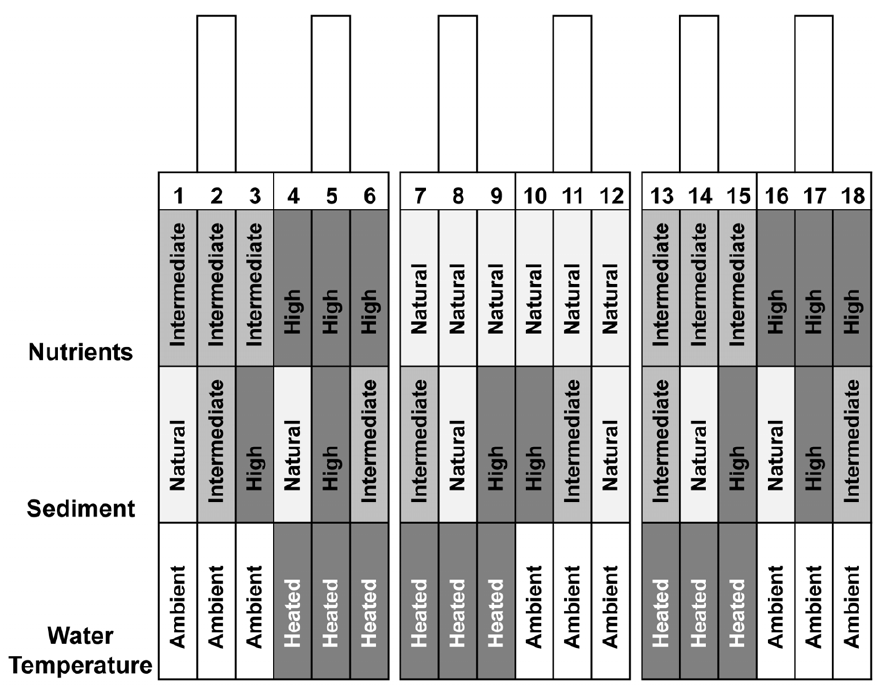
Figure 6. Diagram of the experimental design, showing the 6 inflow pipes (above) and the combinations of ambient and augmented stressors applied to each of the 18 channels.